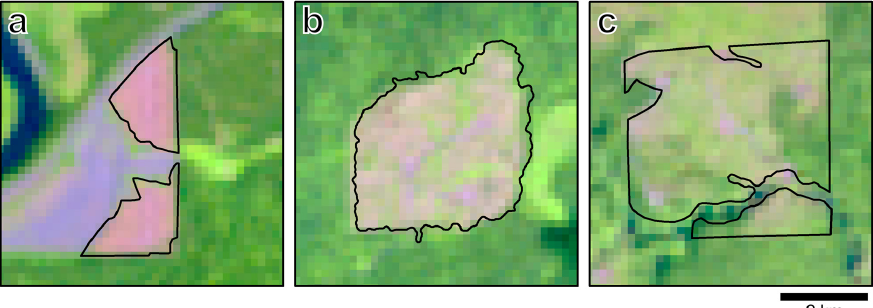
Figure 3. Examples of harvest types in Landsat false color (5 ‐ 4 ‐ 3) composition: clearcut ( a ); clearcut with residual ( b ); and partial cut ( c ). Forests 2017 , 8 , 15